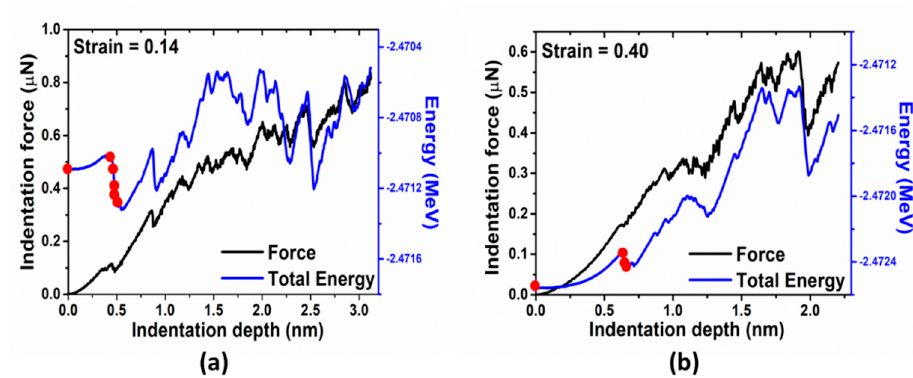
Figure 12. Indentation force and total energy vs. indentation depth for two different prestrain indented with tip radius R = 7.5 nm: ( a ) 0.14 and ( b ) 0.40. Detailed configurations associated with red circles are shown in Figures 13 and 14, respectively.